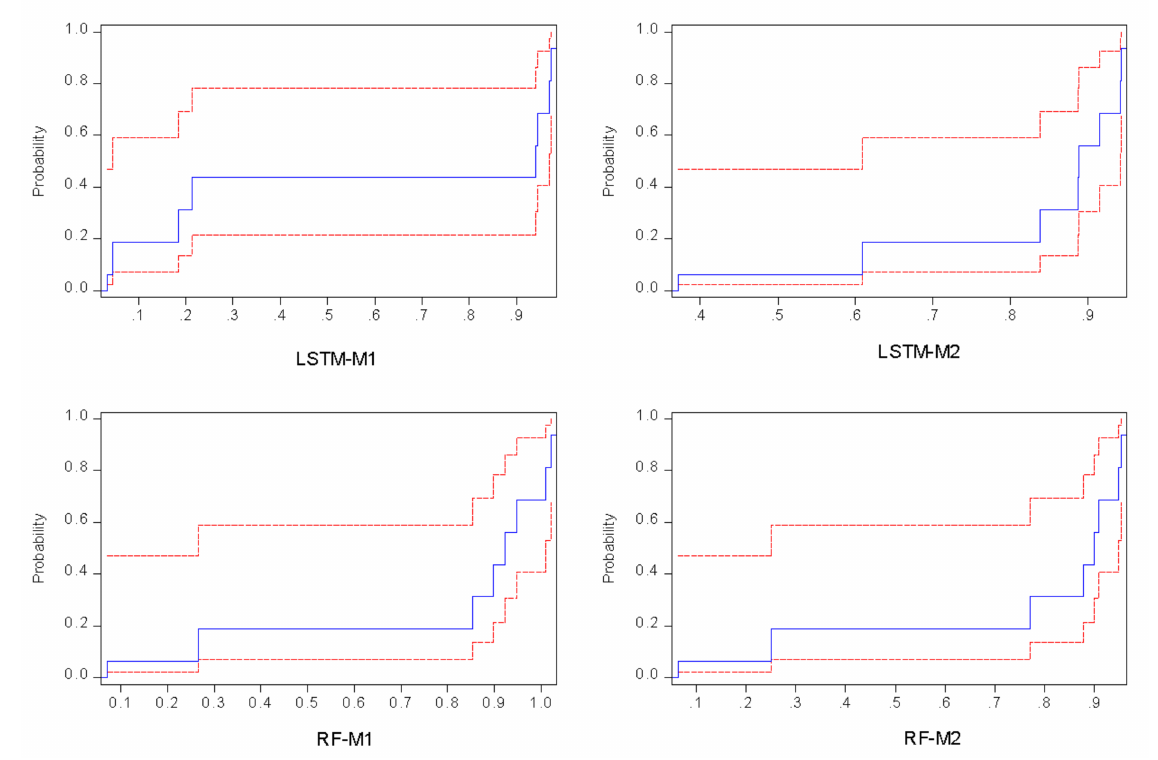
Figure 15. Results of cumulative distribution function for all of the single models.